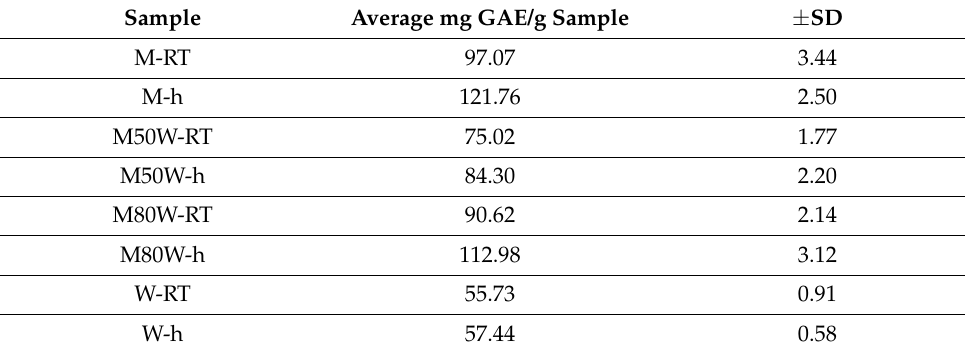
Table A2. The results of F–C assay expressed as average mg GAE/g